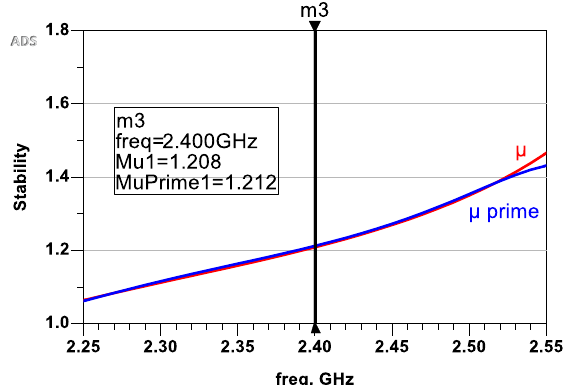
Fig. 16. Small signal gain versus frequency